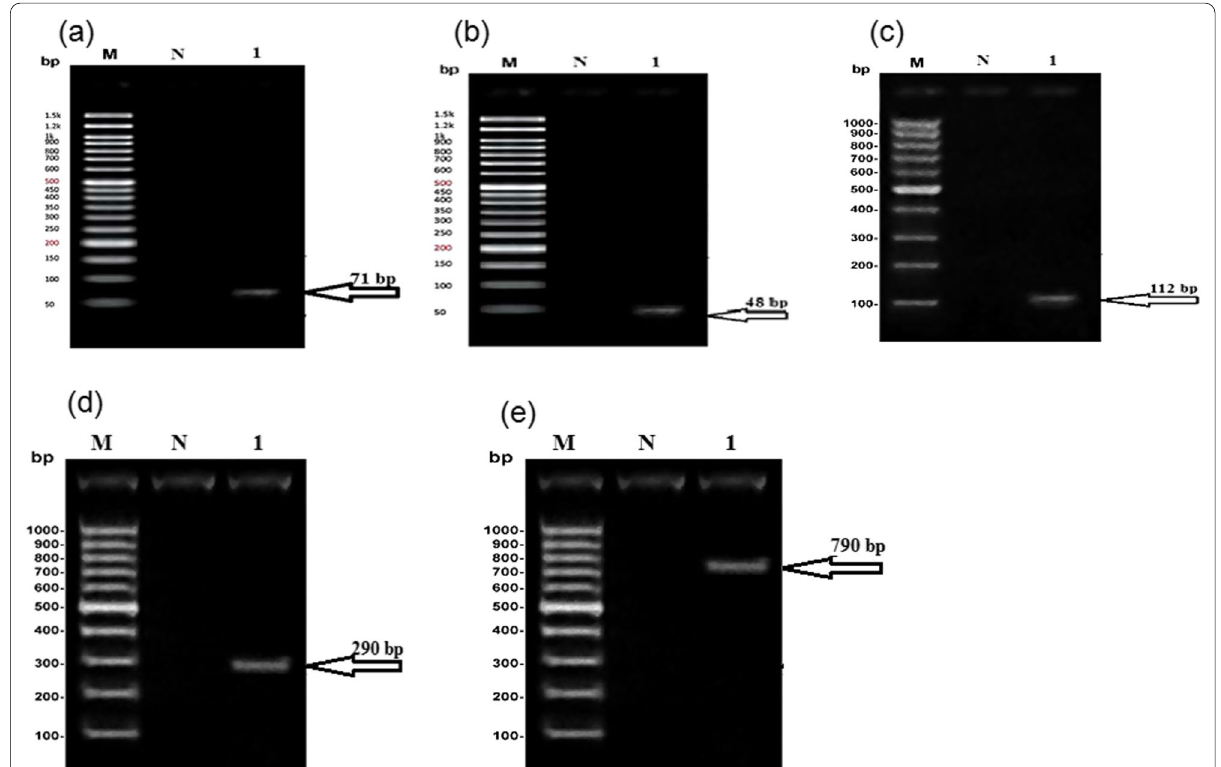
Fig. 2 Ethidium bromide‑stained agarose gel electrophoresis of PCR‑amplified fragments using specific primers represents: a defensin2 shows size 71 bp, b abaecin shows size 48 bp, c hymenoptaecin shows size 112 bp, d juvenile hormone esterase shows size 290 bp, and e vitellogenin shows